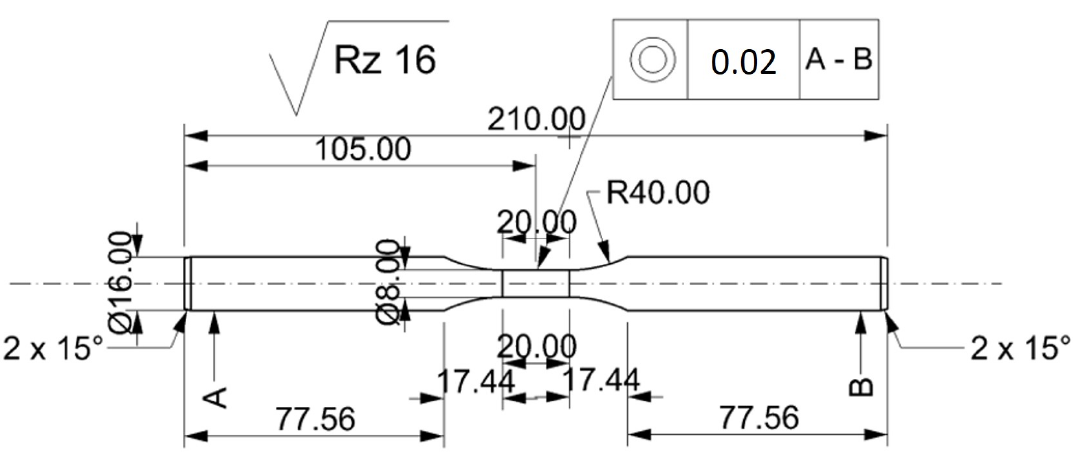
Figure 2. The 5019 aluminium alloy sample’s technical